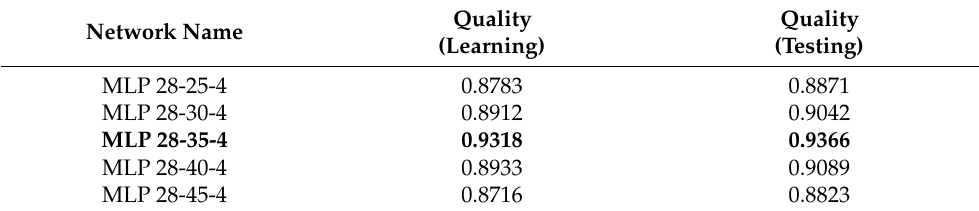
Table 4. Selected ANNs quality assessment.